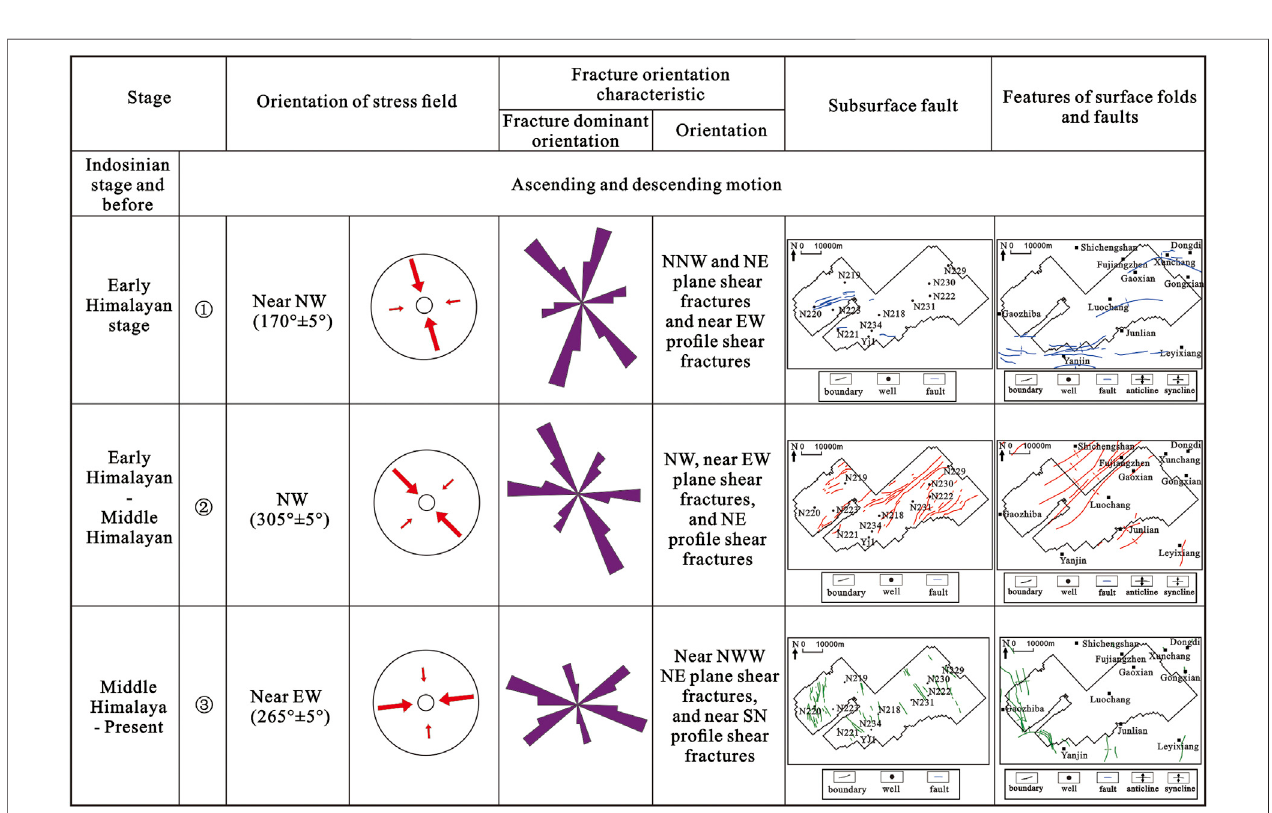
FIGURE 12 | Model for the structural development stages and evolution of the Wufeng-Longmaxi Formation in the Yanjin – Junlian area.